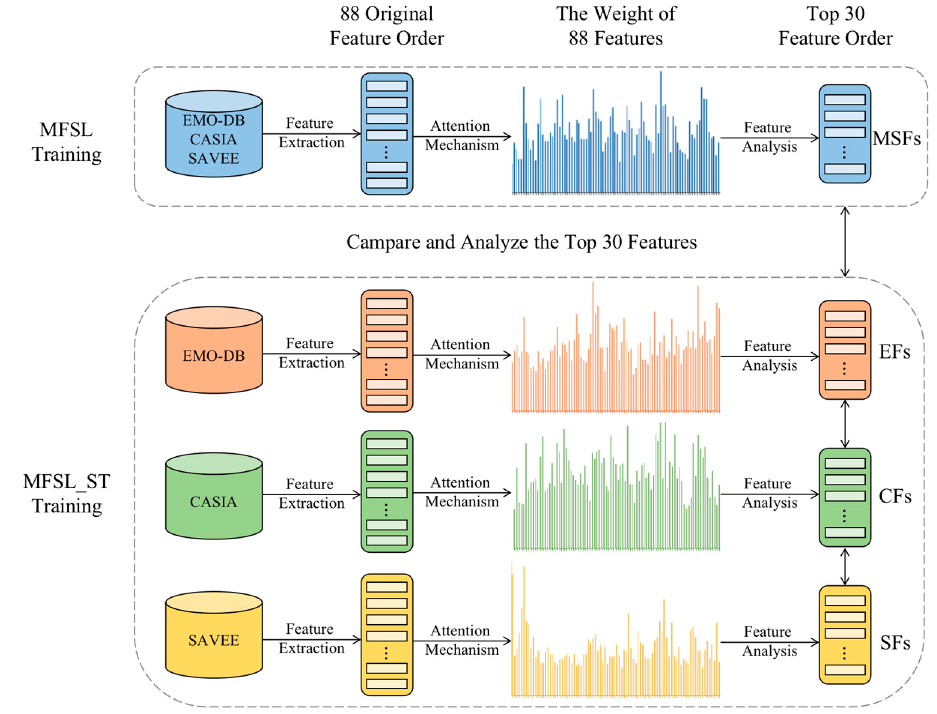
Figure 7. The feature ranking and comparison procedure based on the attention mechanism.